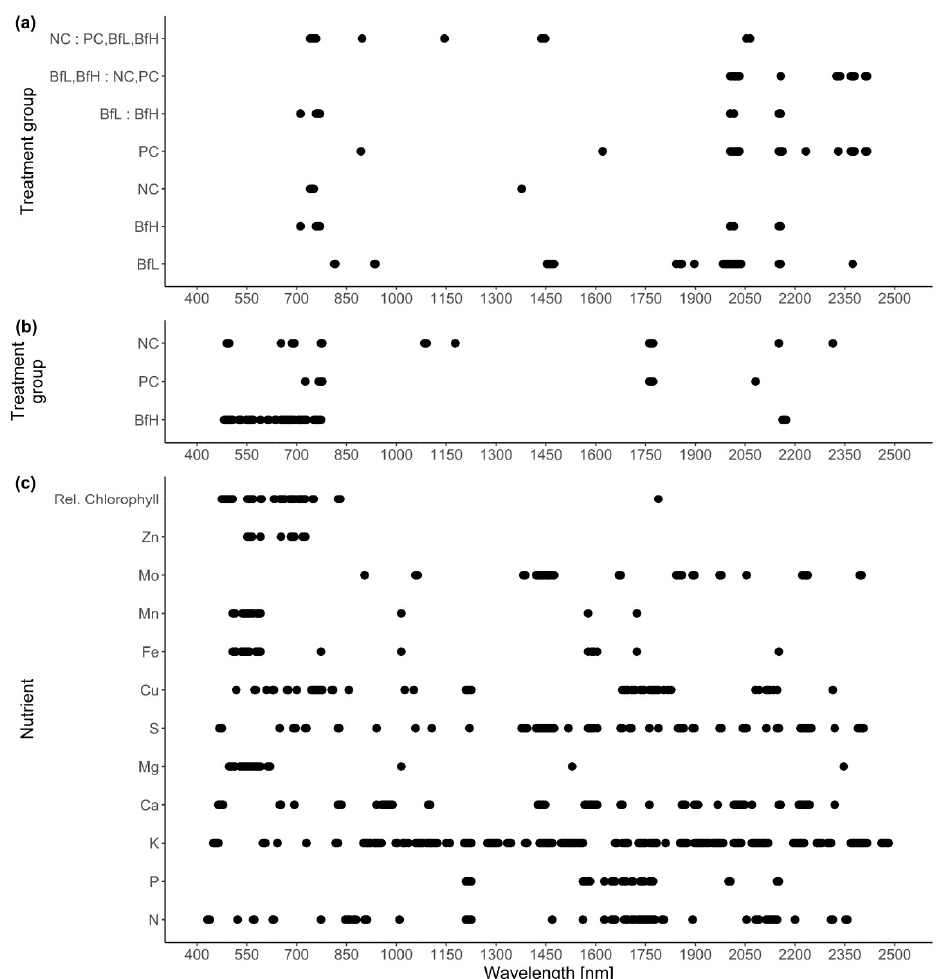
Figure 9. Loadings of the first partial least squares discriminant analysis (PLS-DA) ( a , b ) and partial least squares regression (PLS-R) ( c ) component for the pooled samples. The data points show spectral ranges with correlation values higher than 0.7 or lower than −0.7 in ( a ) the pot experiment, ( b ) the microplot experiment and ( c ) the nutrient content datasets. NC—negative control; PC—positive control (nematicide); BfL—low B. firmus inoculum; BfH—high B. firmus inoculum.